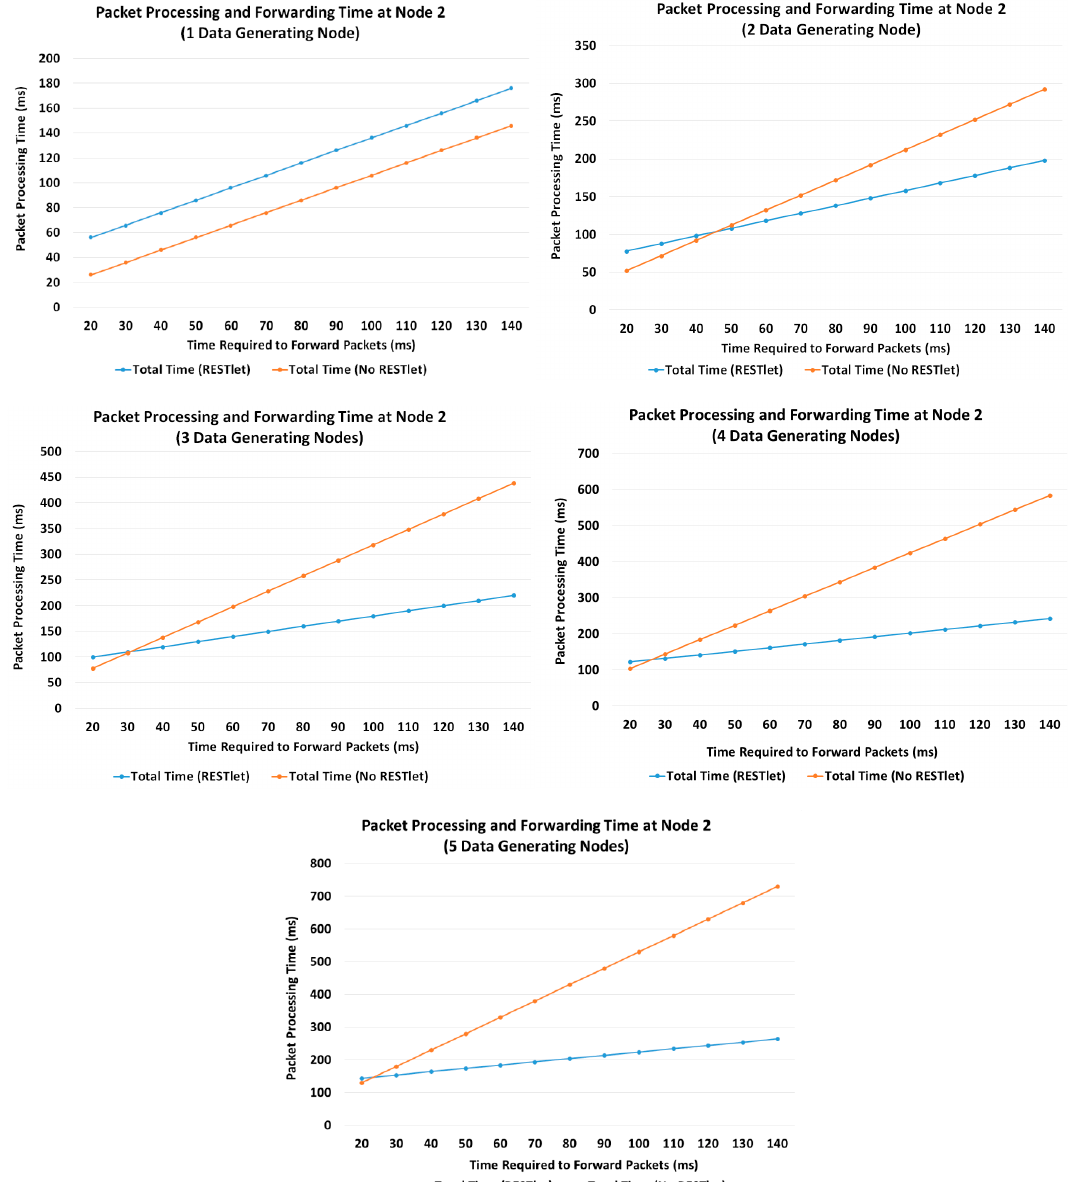
Figure 19. Packet Processing and Forwarding time at RESTlet Node for Various Number of Data Generating Nodes.